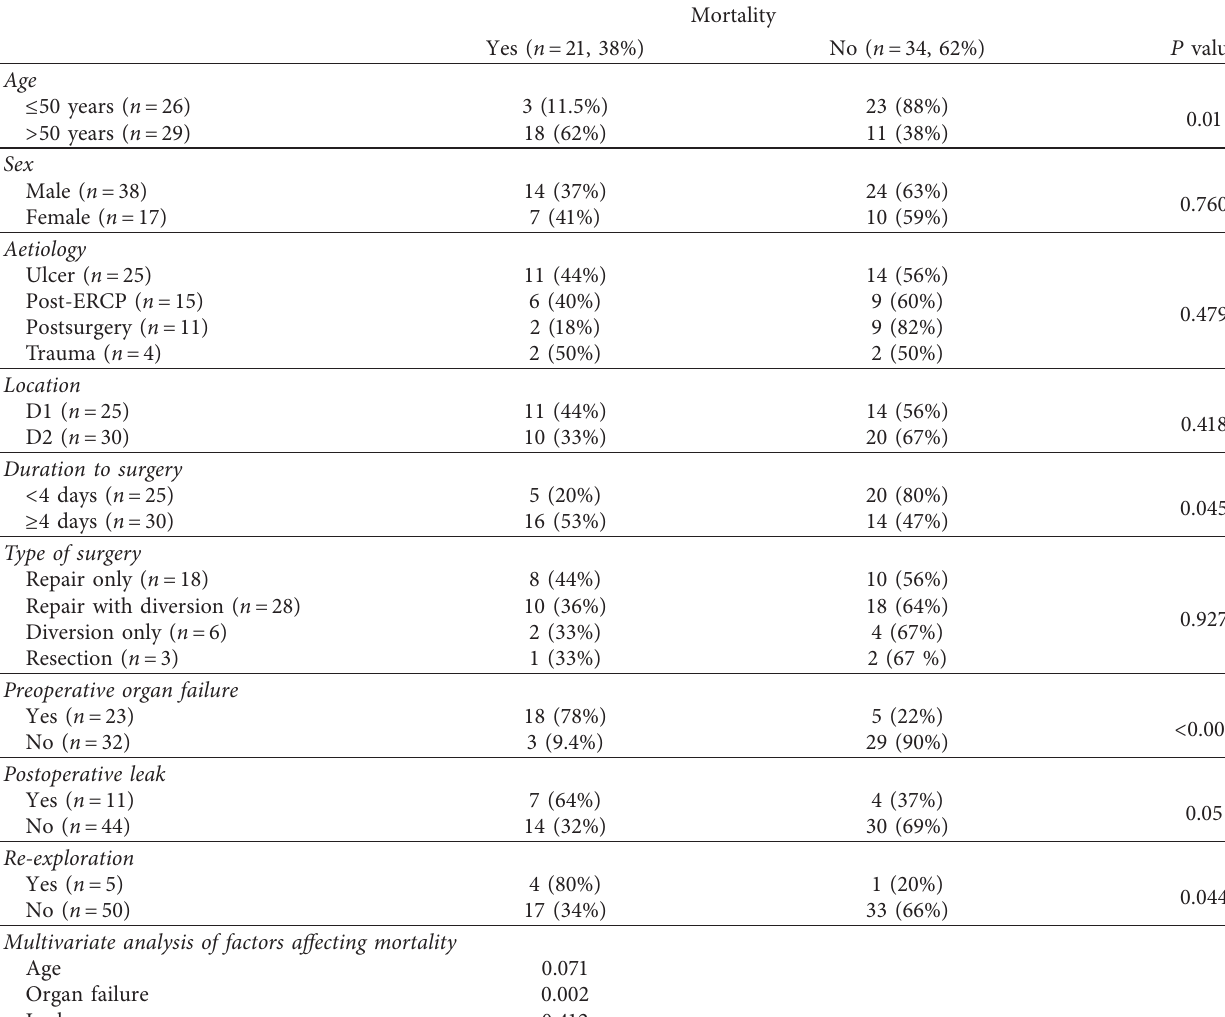
Table 3: Association of mortality with preoperative, intraoperative and postoperative variables, and multivariate analysis for factors affecting mortality.